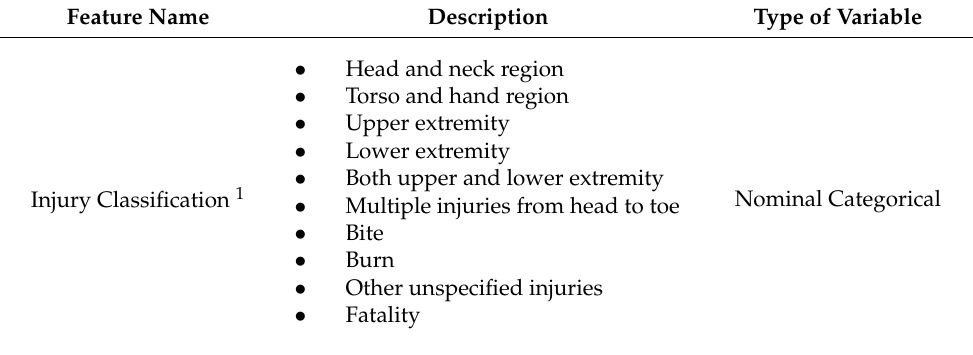
4 Table 2. Response Variable. Feature Name